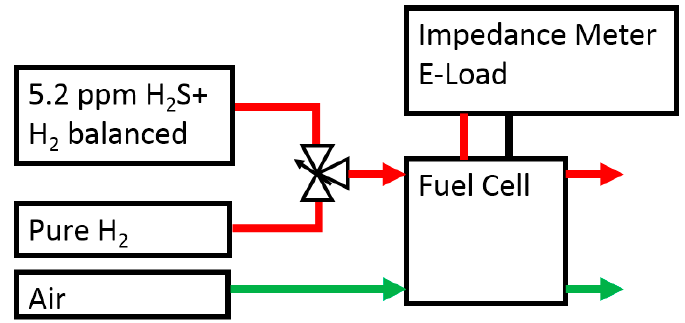
Figure 7. Experimental setup for investigating effect of hydrogen sulfide on high-temperature proton exchange membrane fuel cell (HT-PEMFC) performance.